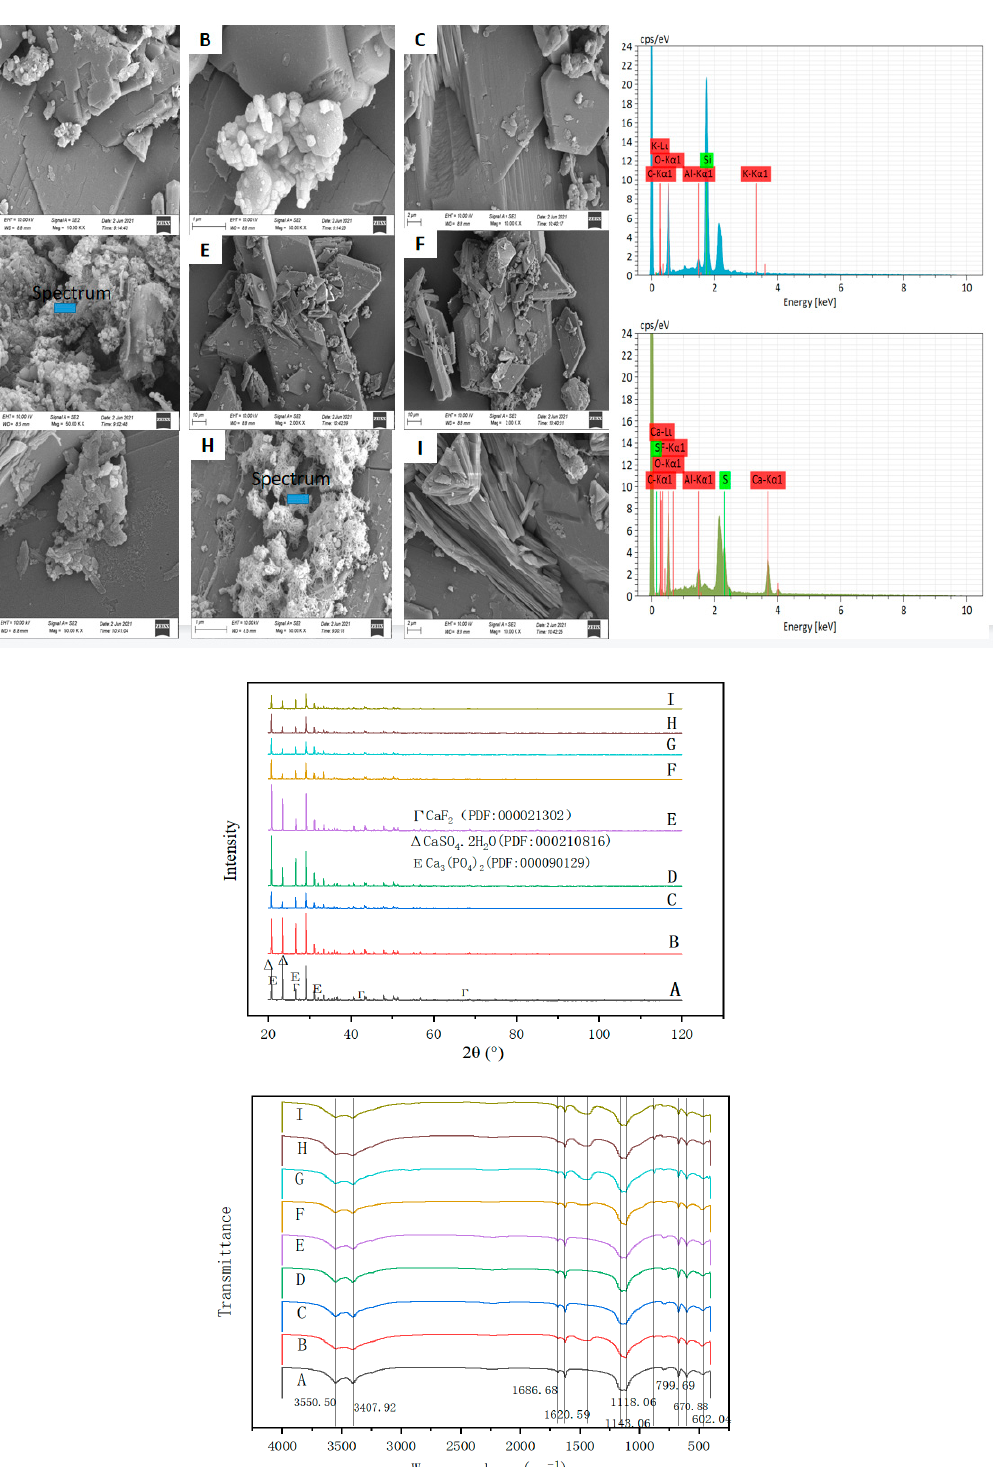
Figure 12. Characterization of different formulations by SEM-EDS, XRD and FTIR. ( A -21, B -22, C - 23, D -24, E -25, F -26, G -27, H -28, I -29).